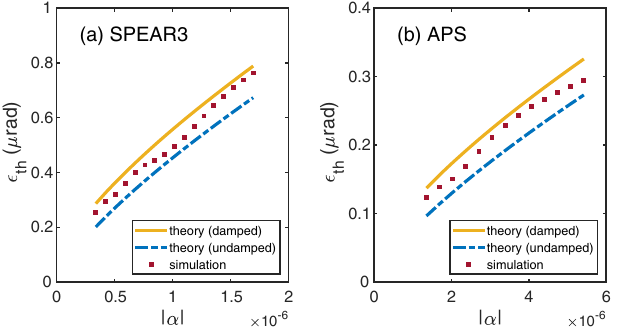
FIG. 4. Comparison of the simulated drive amplitude threshold dependence on the sweep rate to the theory for the (a) SPEAR3 and (b) APS storage rings.